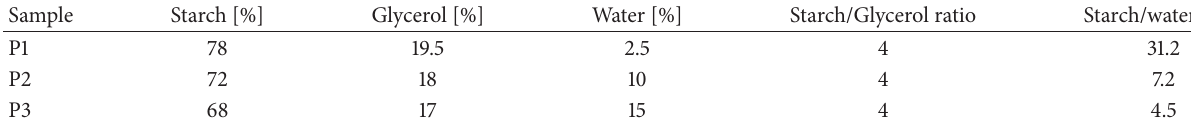
Table 1: The composition of samples.